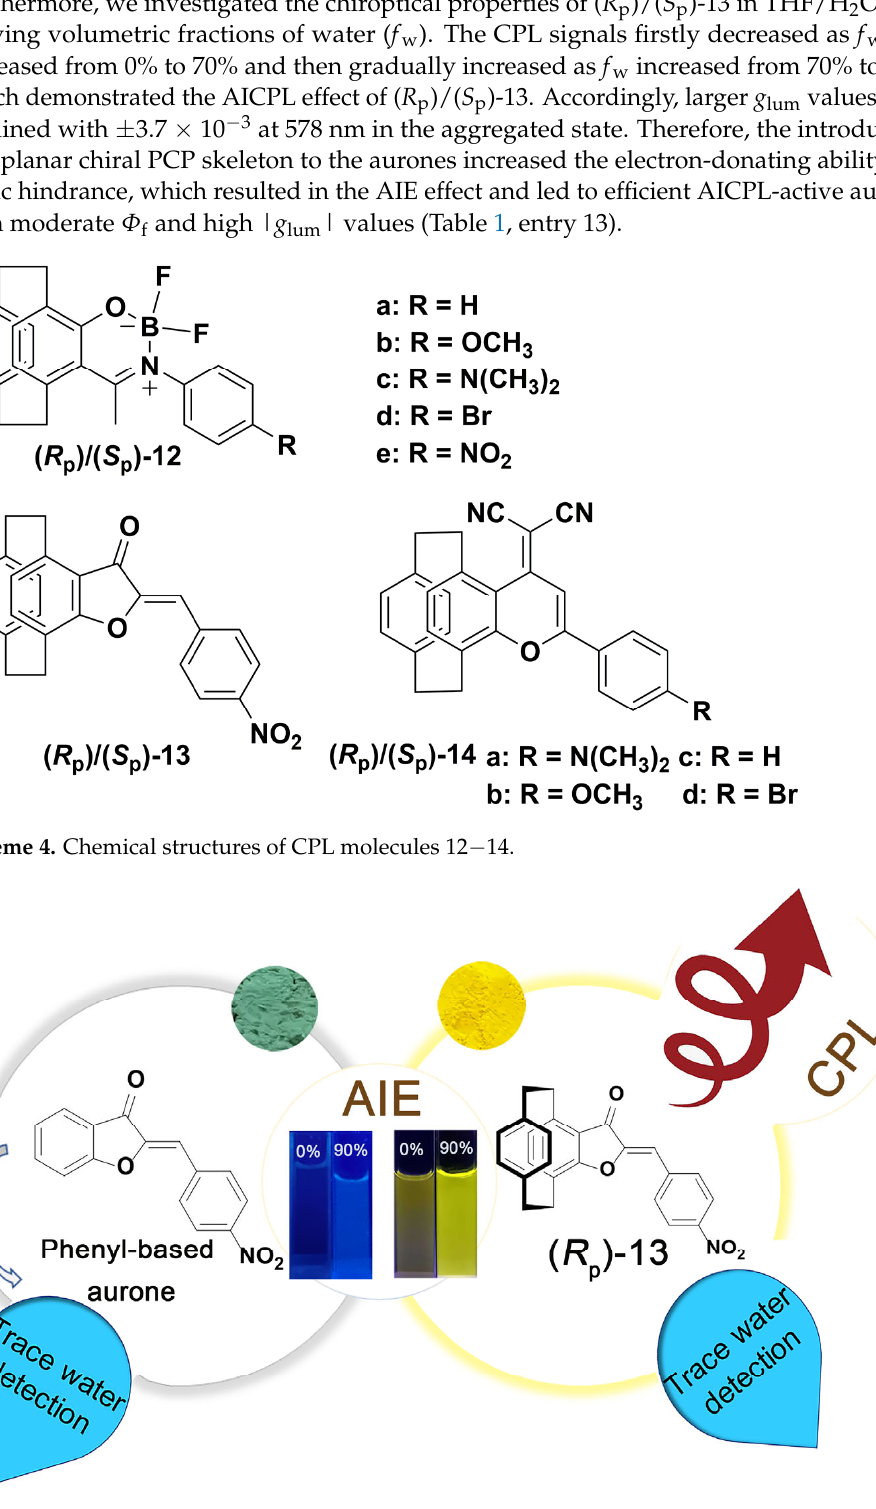
Figure 4. Comparison of phenyl-based aurone and PCP-based aurone ( R p ) ‐ 13. In 2023, our group also reported a series of PCP ‐ based 4 ‐ (dicyanomethylene) ‐ 4 H ‐ py ‐ ran compounds ( R p )/( S p ) ‐ 14a − d by introducing a dicyanovinyl group to modify the planar 4 H ‐ pyran ‐ 4 ‐ one compounds 11 (Scheme 4) [30]. We also investigated the X ‐ ray structures, TD ‐ DFT calculations, electrochemical properties, and photophysical properties in solu ‐ tion and solid state. The results demonstrated that these compounds exhibited AIE prop ‐ erties at f w = 99% and showed intense photoluminescence, with the color changing from orange to deep red with high Φ f of up to 97% in solid state. These results indicated that the introduction of PCP and a dicyanovinyl group could hinder intermolecular π – π stack ‐ ing interactions and enhance the ICT process, which led to the high solid ‐ state Φ f and deep red color. We then investigated the CD spectra of ( R p )/( S p ) ‐ 14a,b in THF/H 2 O mixture with different f w . The results showed that the CD signals were both enhanced when f w was increased to 90%. Meanwhile, we investigated the CPL behaviors of ( R p )/( S p ) ‐ 14a,b in ag ‐ gregated and solid states. Interestingly, ( R p )/( S p ) ‐ 14a,b were CPL silent either in THF so ‐ lutions or in aggregated states, which may have been due to the weak emission of ( R p )/( S p ) ‐ 14b and the low ‐ degree oligomeric stacking of ( R p )/( S p ) ‐ 14a in the aggregated state determined by the FE ‐ SEM images. However, ( R p )/( S p ) ‐ 14a,b exhibited intense CPL signals in a solid state, and the signals were centered at 662 and 617 nm with | g lum | values of 1.9 × 10 − 3 and 1.8 × 10 − 3 , respectively. In comparison with most reported PCP derivatives, ( R p )/( S p ) ‐ 14a exhibited a longer CPL maximum wavelength and higher Φ f . These results suggest that the unique structure of the planar chiral PCP skeleton and the strong ICT process can be utilized in preparing red AICPL materials. 3. Conclusions In this review, we summarized the different applications of the PCP skeleton in the fields of dye modification, fluorescent probes in detection, and CPL modulation. Firstly, regarding dye modification, we demonstrated the PCP skeleton could provide a 3D struc ‐ ture for coumarin systems, and that these coumarins showed extremely large Stokes shifts (up to 230 nm) and red ‐ shifted absorption and emission bands. Furthermore, the analysis of BODIPY dye (PCP ‐ BODIPY dyes 6, 8) revealed that the introduction of a PCP group could increase steric hindrance and prevent π – π stacking, thus improving the fluores ‐ cence properties of dyes and inducing J ‐ aggregation. Because of the conjugation effect and steric effect of the PCP group, PCP ‐ BODIPY dye 8 showed both NIR ‐ I ( J 1 ‐ band, 900 nm) and NIR ‐ II ( J 2 ‐ band, 1010 nm) emission in THF–water binary solvent and could be used for lymph node imaging and fluorescence ‐ guided surgery in nude mice.